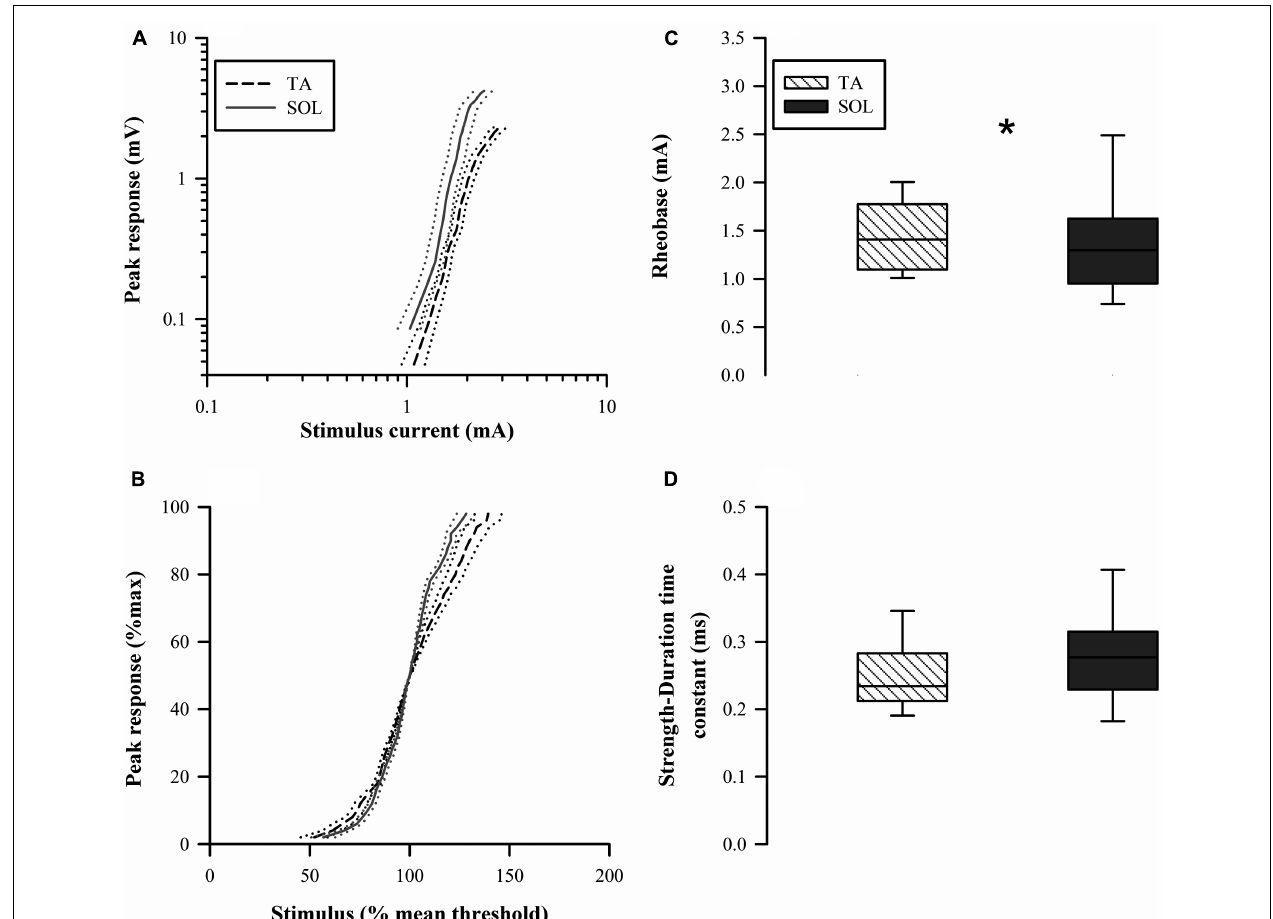
FIGURE 5 | Raw stimulus-response curves (A) are shifted to the right for TA axons indicating higher threshold. The normalized stimulus-response curves (B) indicated that the relative slope is less forTA axons. (C) Rheobase